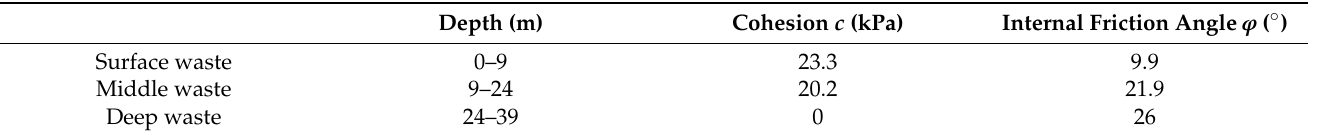
Table 2. Strength parameters of MSW with different